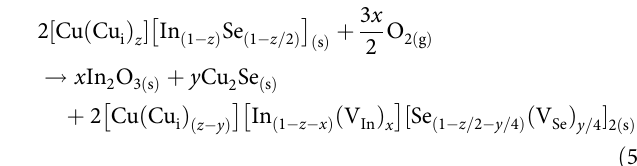
Figure 4b, c exemplify the extreme cases of interface reactions from the perspective of CIS point defects under Cu de fi ciency and Cu excess, as inferred from the experimental evidence. The driving force for Eq. (5) to happen, but the Cu excess in Cu-rich CIS appears to increase the reaction rate compared with Cu-poor CIS, which can be represented by a lowering of the reaction energy barrier, as suggested in Fig. 4d.